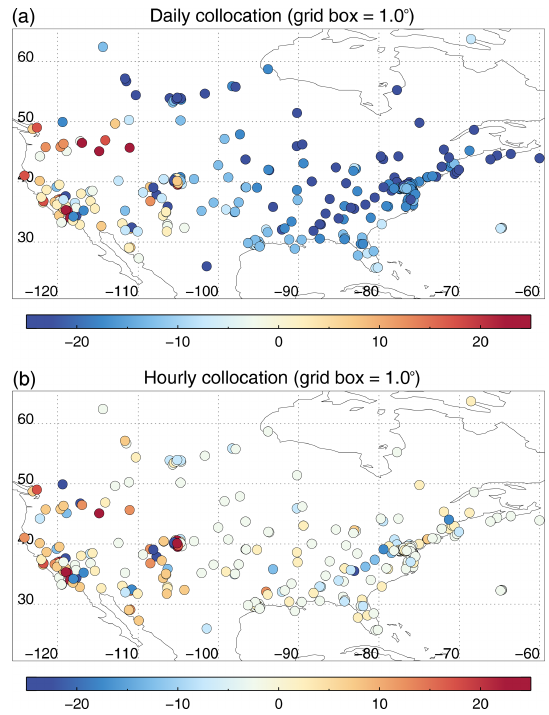
Figure 5. Yearly representation errors (%) for AOT from AERONET direct sun L2.0 in North America, for two different col- location protocols ( a daily; b hourly) and a model grid-box size of 1 ◦